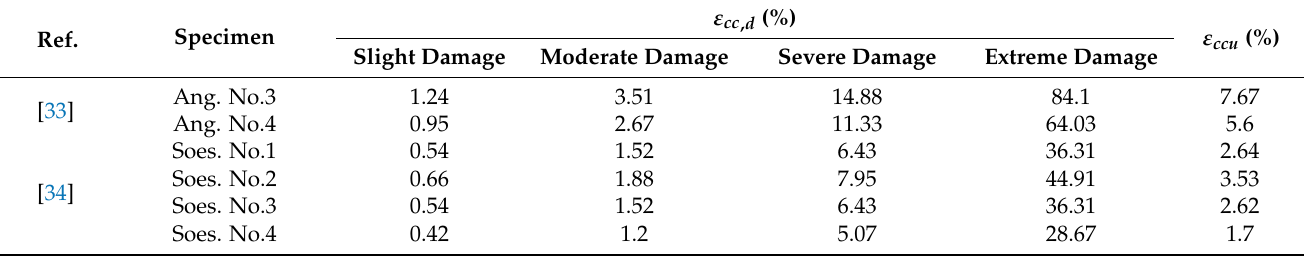
Table 1. The damaged strain of extreme fibers of confined concrete in the RC